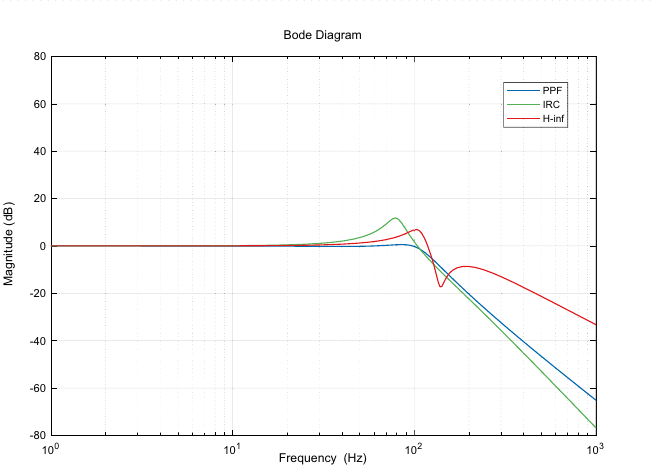
Figure 9. Results of the system tracking a 20 Hz grating scan signal at a mechanical load of 1000 g.